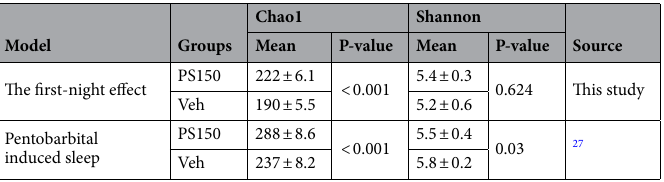
Table 1. Alpha diversity indexes. Statistical significance was calculated using the t